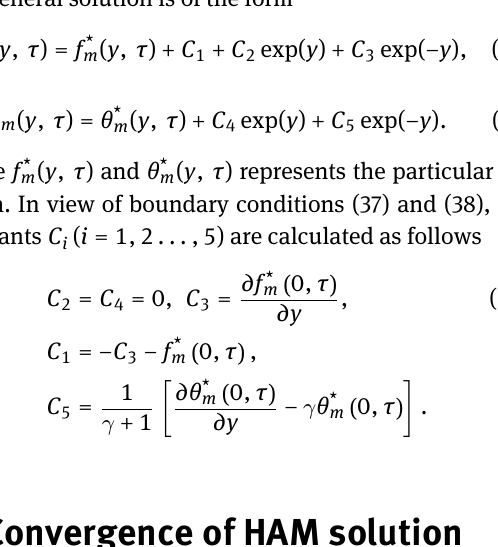
The general solution is of the